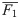
Differences between pairs of estimation procedures according to the Wilcoxon signed-rank test.Compared are the average absolute errors, measured by Alpha (top) and F1¯ (bottom). Thick solid lines denote significant differences at the 1% level, normal solid lines significant differences at the 5% level, and dashed lines insignificant differences. Arrows point from a procedure which incurs smaller errors to a procedure with larger errors.